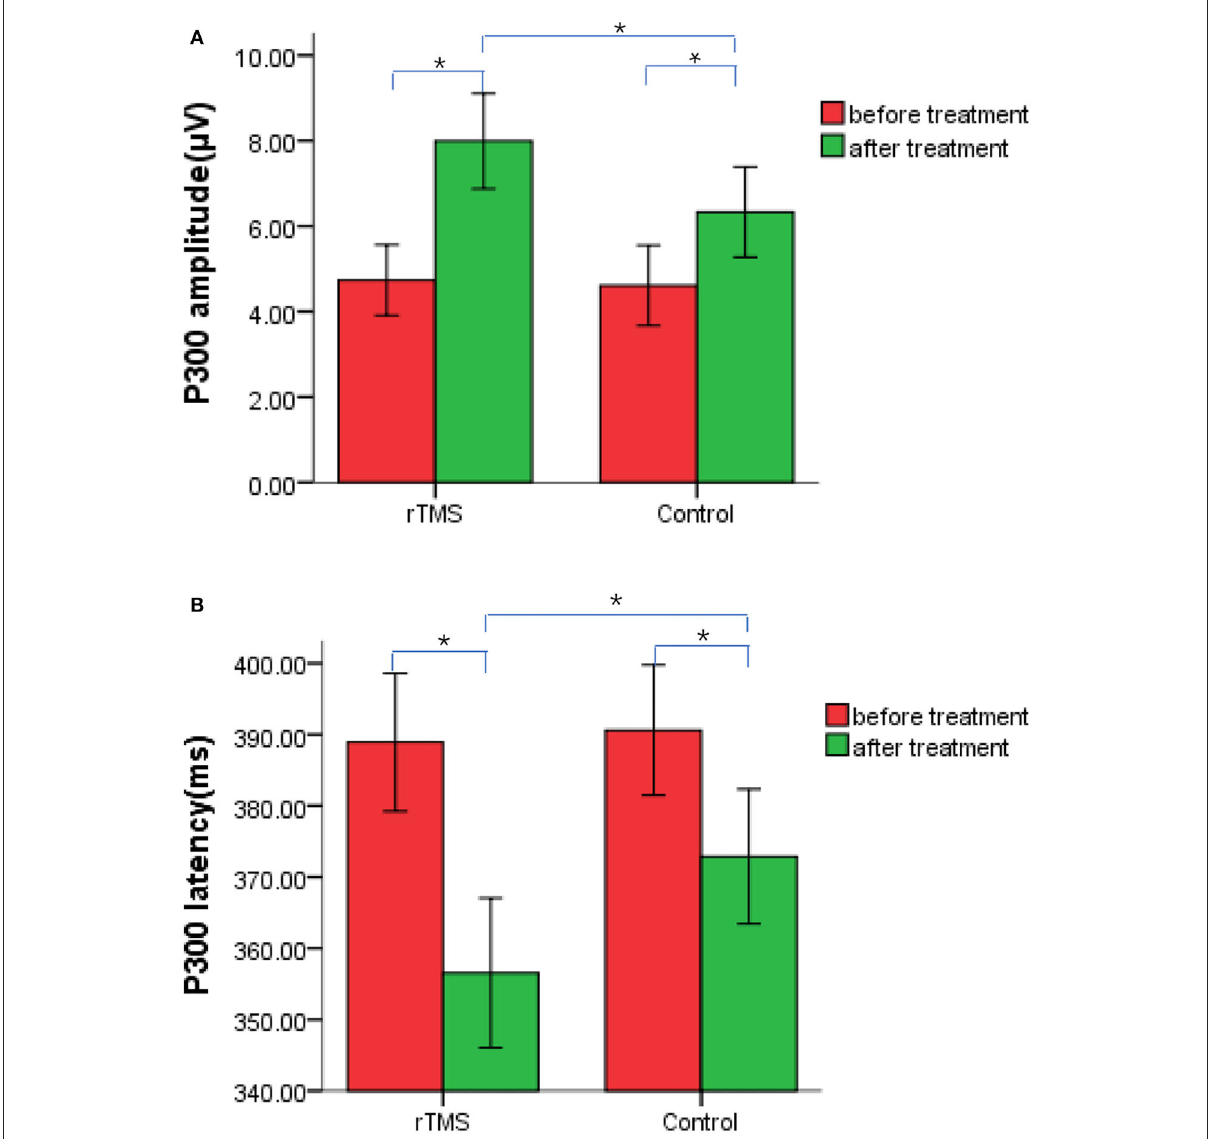
FIGURE4 Differences in p300 wave latencies and amplitudes before and after treatment with repetitive transcranial magnetic stimulation (rTMS) therapy in patients from both the rTMS treatment and control groups. (A) P300 amplitude. (B) P300 latency. * P < 0.05.